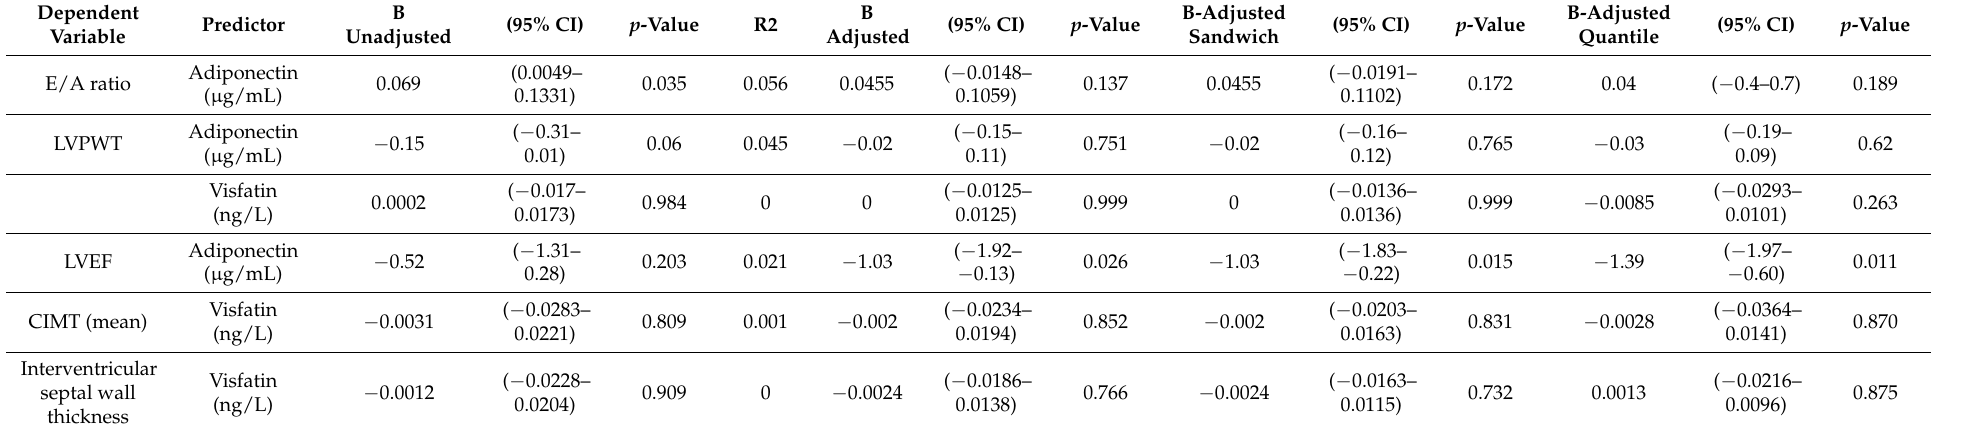
Table 3. Univariate and multivariate linear regression models and multivariate quantile regression models predicting E/A ratio, LVPWT, LVEF, CIMT (mean) and interventricular septal wall thickness in relation to adiponectin or visfatin, adjusted for MAFLD, sex, diabetes, SBP, DBP, LDL and